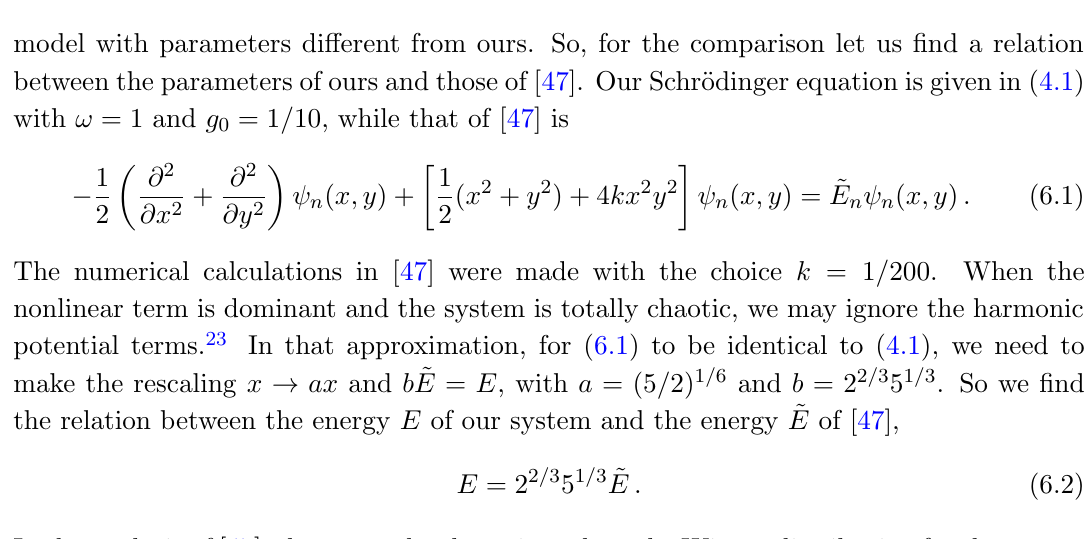
Figure 11 . The exponent c as a function of (cid:28) Max . Each (cid:28) Max corresponds to a di(cid:11)erent initial condition for the numerical calculation of the classical Lyapunov